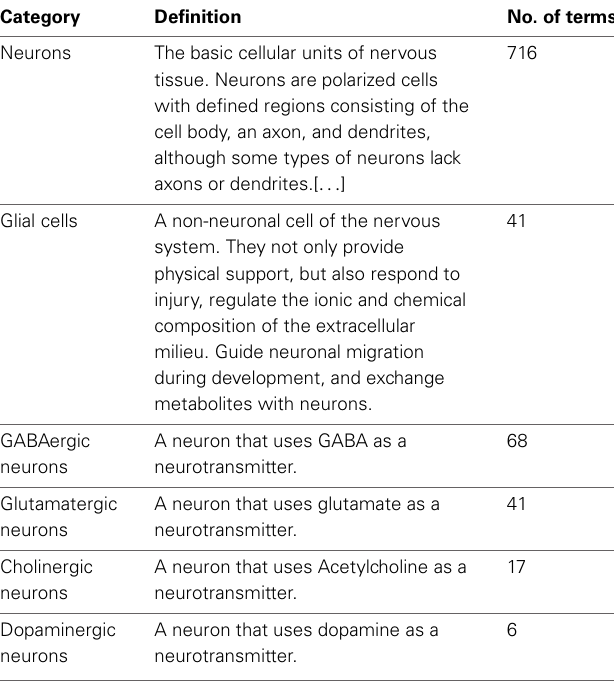
Table 2 | Nervous system cells in the